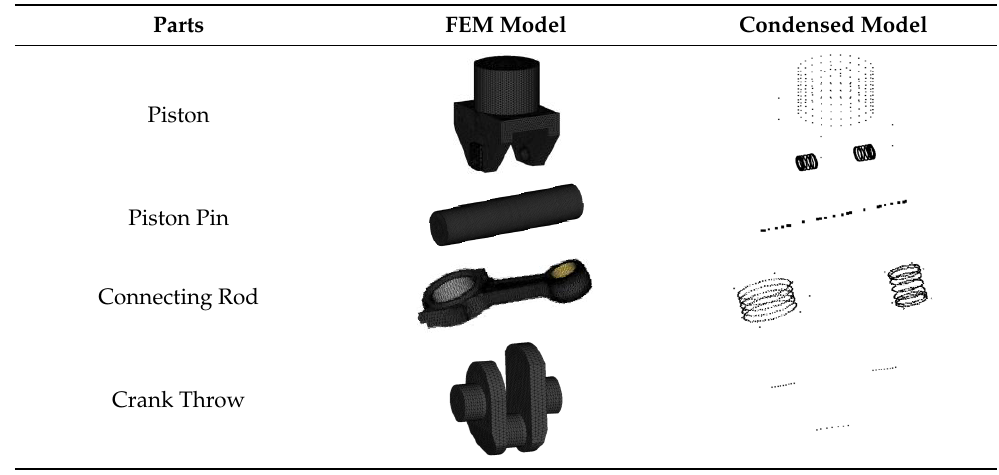
Table 2. FEM and condensed models of main components.